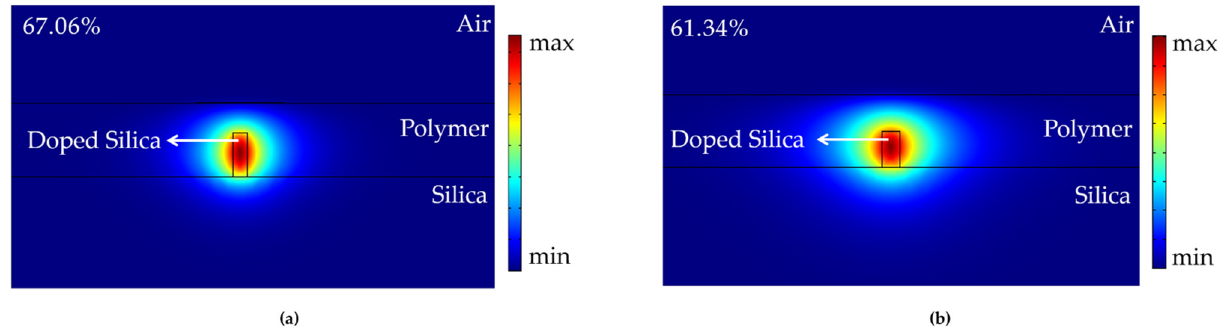
Figure 3. Relationship between the minimum temperature and the width of the core in the heating region for the electrode widths of 3 and 6 µm.